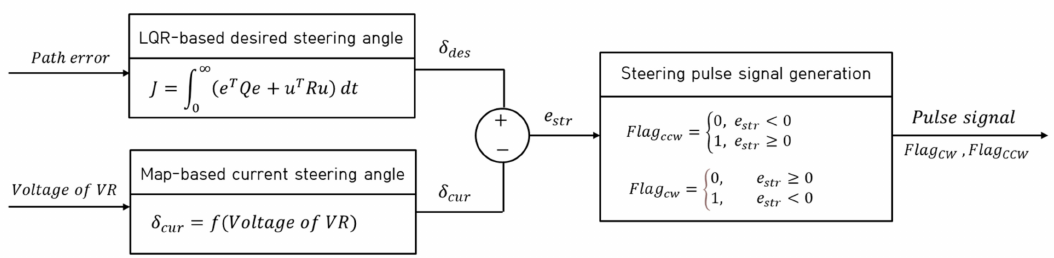
Figure 5. Block diagram for steering control algorithm for path